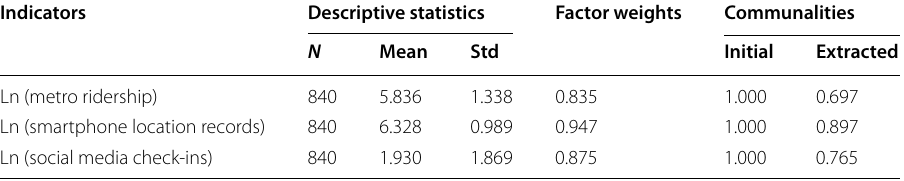
Table 1 The solution of the factor analysis and descriptive statistics of the surface attributes Indicators Descriptive